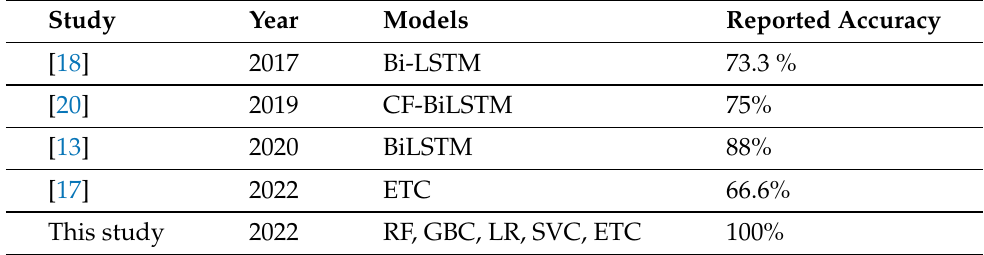
Table 18. Comparison with existing